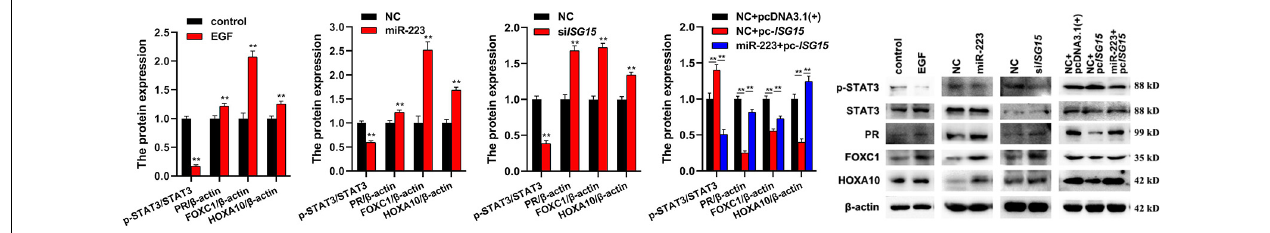
FIGURE 4 | Effects of EGF, miR-223, and ISG15 on gMEC inflammation. The regulation of inflammation-related protein expressions (p-STAT3, PR, FOXC1, and HOXA10) by EGF, miR-223, and ISG15 was detected, and it showed that EGF, miR-223, and si ISG15 significantly decreased the expression of p-STAT3 and elevated the expressions of PR, FOXC1, and HOXA10 in gMEC. Pc- ISG15 promoted the expression of p-STAT3 and reduced the expressions of PR, FOXC1, and HOXA10 in gMEC, while miR-223 weakened its regulation. EGF has been reported to surge at the onset of lactation, suggesting its importance in the lactation process. In this study, we found that the expression of miR-223, a conserved anti-inflammatory miRNA, could be induced by EGF. The downstream differentially expressed genes of miR-223 were screened by RNA-seq, and abundant interferon stimulated genes were found to be regulated by miR-223, including ISG15 , a pivotal immune responder. Therefore, we explored the role of EGF, miR-223, and ISG15 in goat mammary epithelial cell apoptosis and inflammation to elaborate how mammary gland could be protected from mastitis during lactation. ** p <